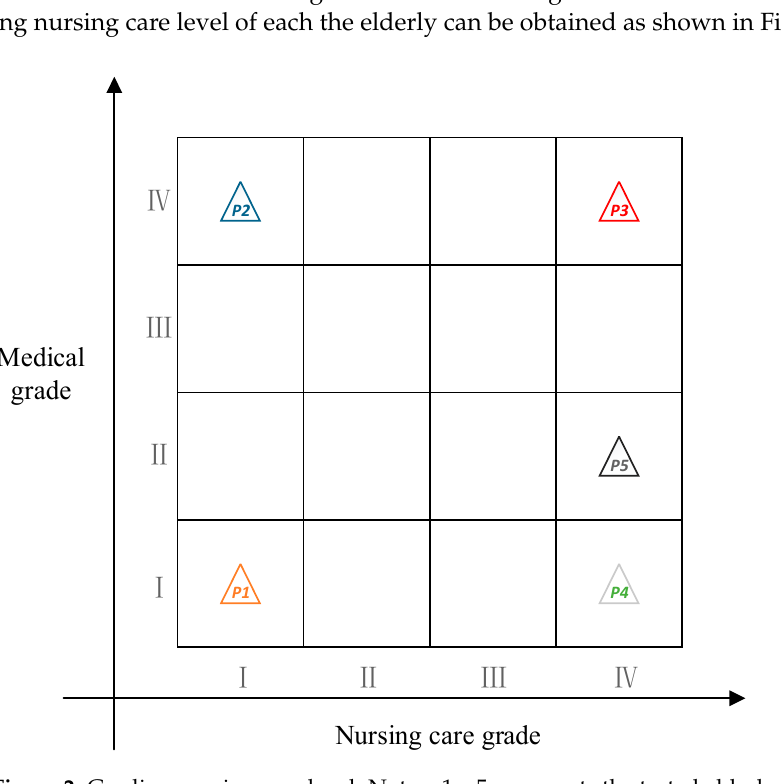
Figure 2. Grading nursing care level. Note: p 1– p 5 represents the tested elderly, I–IV represents the care